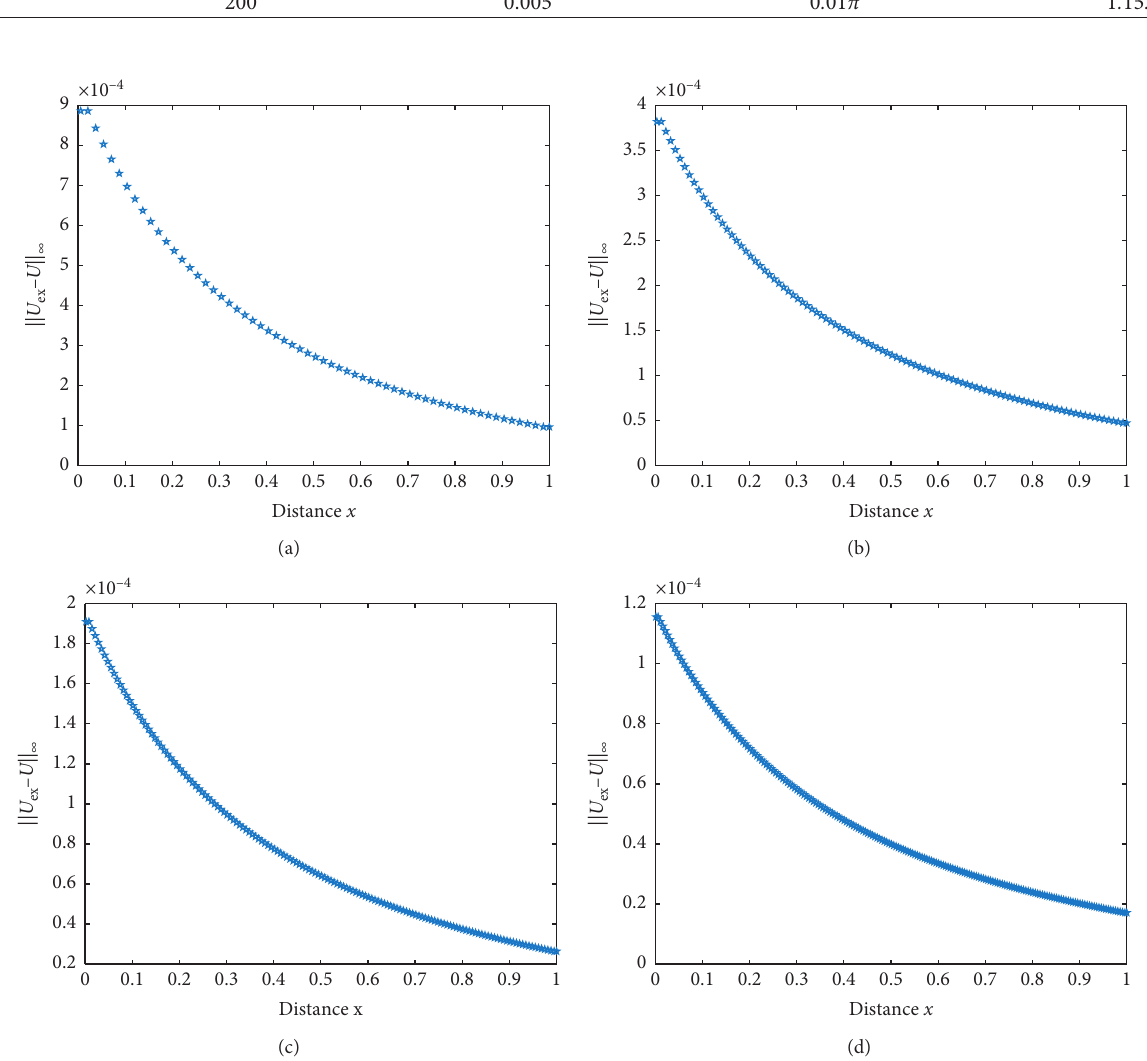
N � 60. (b) The error for N r